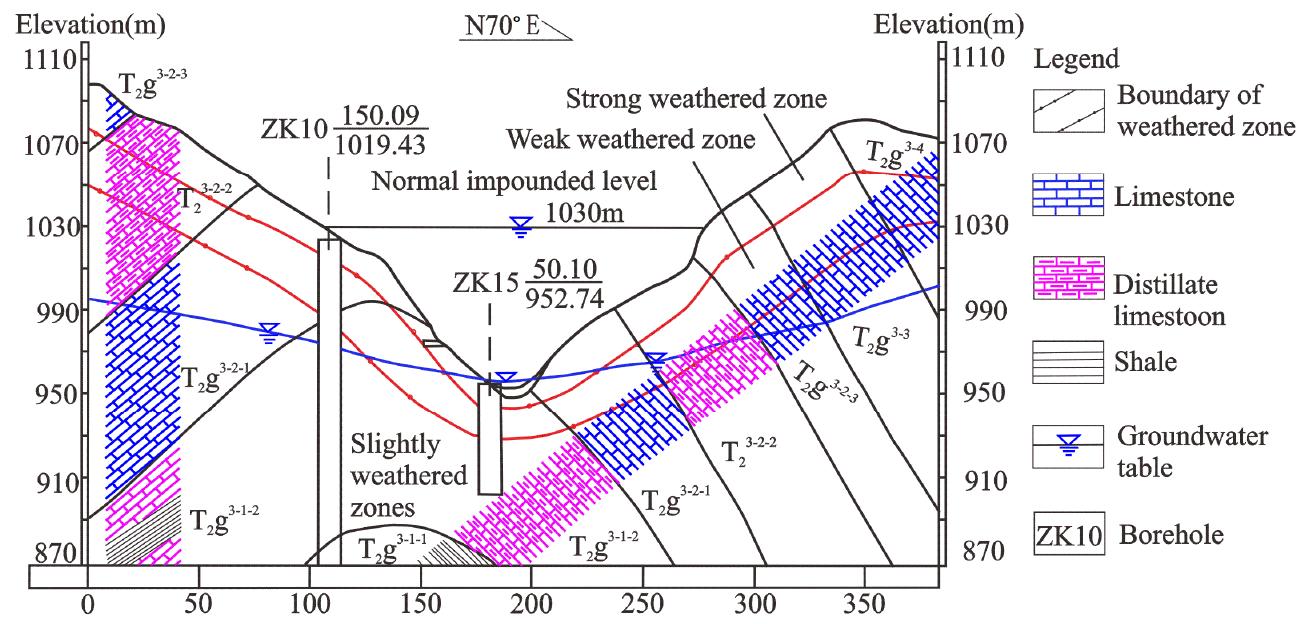
Figure 2. Geological profile of dam axis.